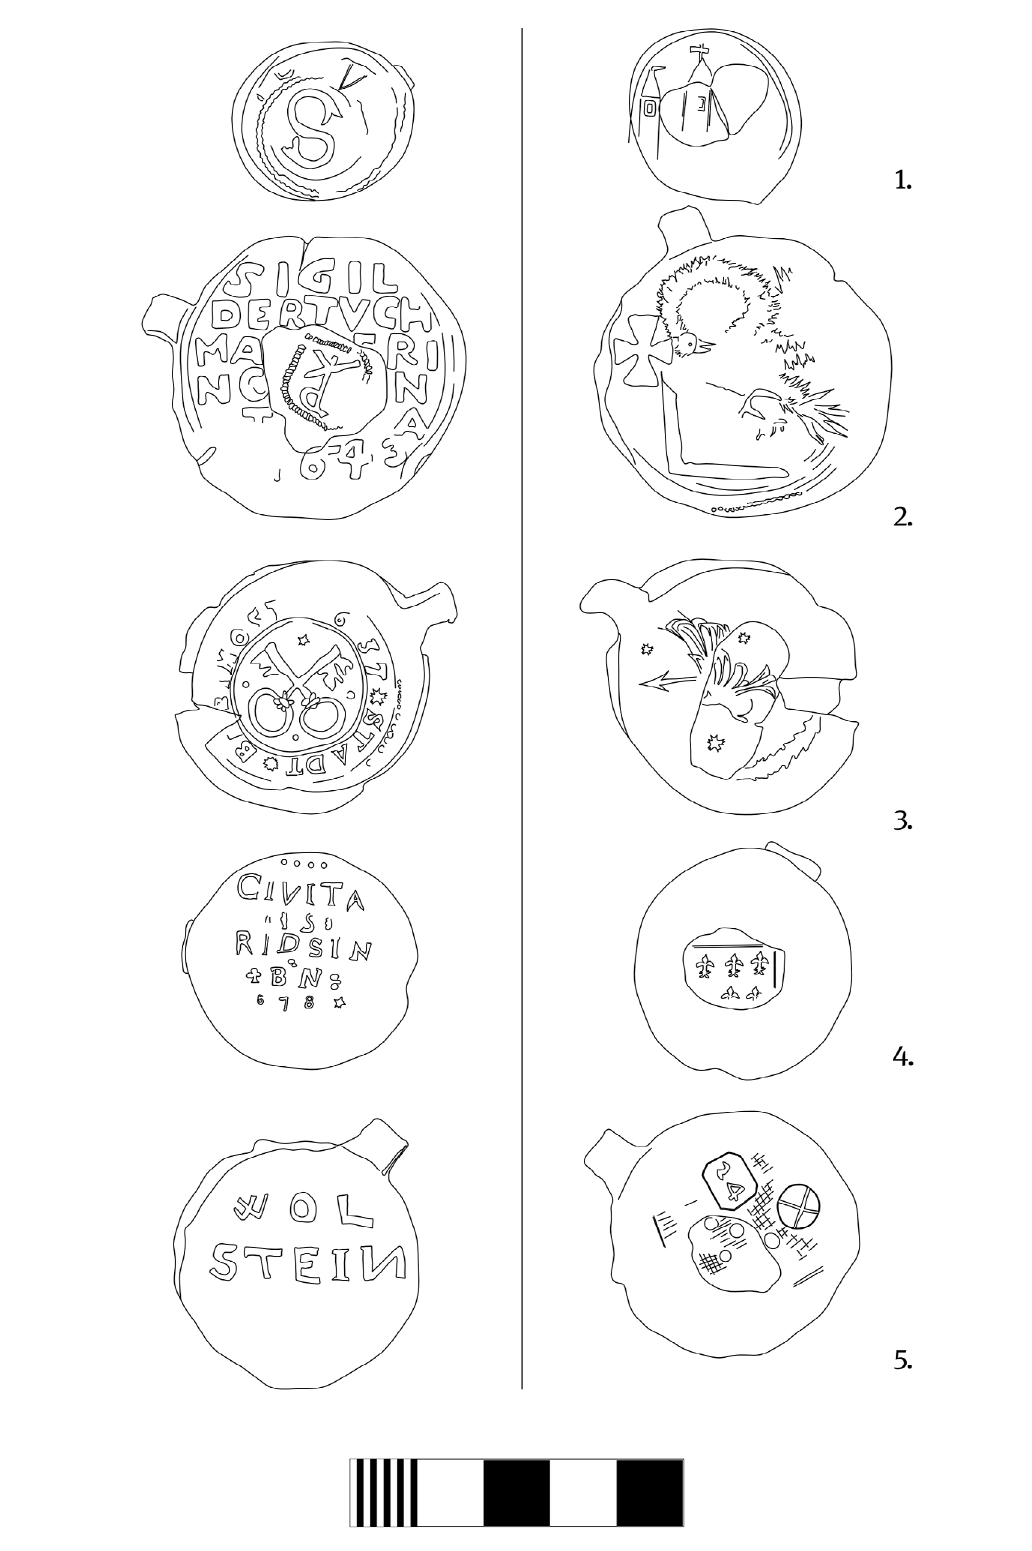
Figure 26. Lead seals originated from Sierpc (1), Grabów (2), Babimost (3), Rydzyna (4), Wolsztyn